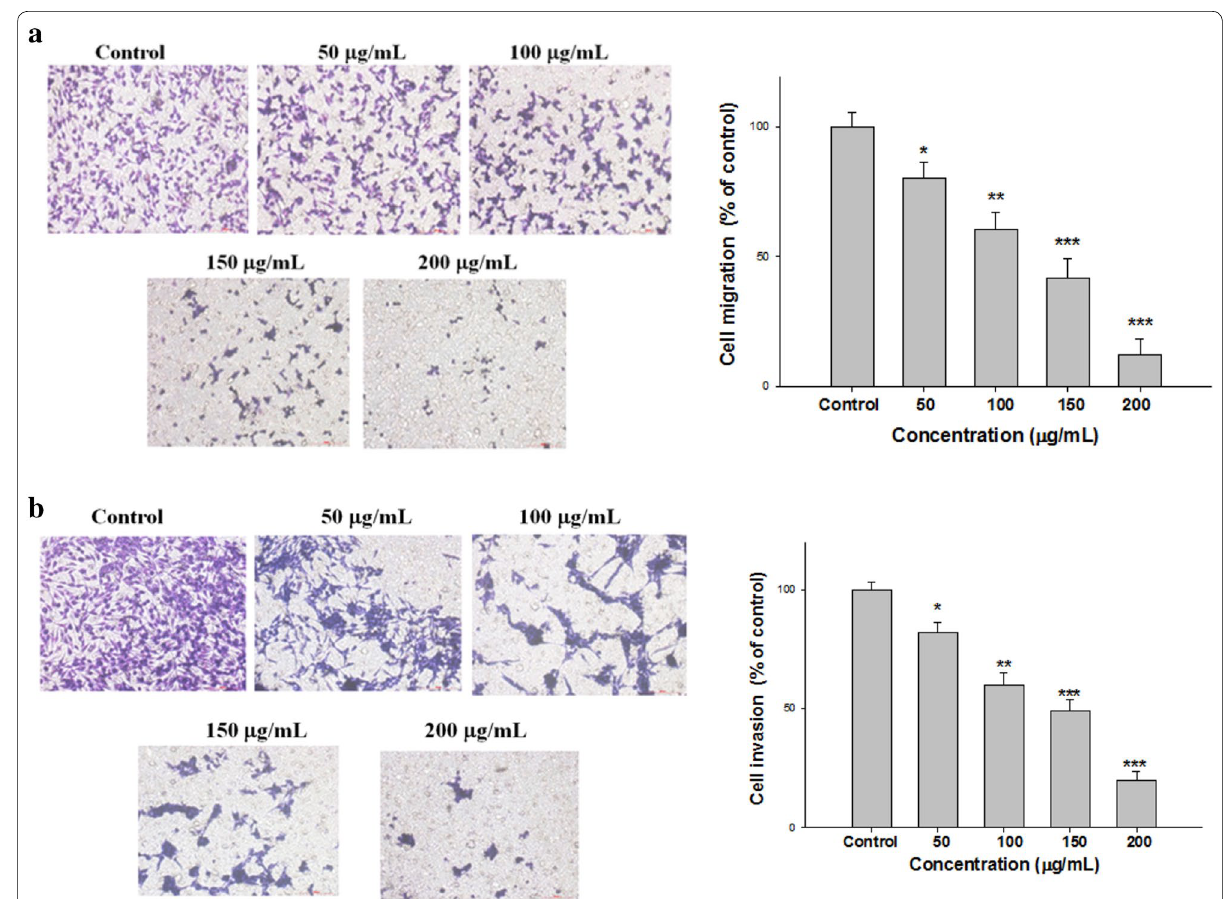
Fig. 3 Effects of EAAC on transwell migration ( a ) and invasion ( b ) of SK‑Hep1 cells. SK‑hep1 cells were incubated with EAAC (0, 50, 100, 150, and 200 μg/mL) for 24 h, and the transwell migration cells and invasion cells were counted. The data were presented as mean experiments performed in triplicate. * p < 0.05, ** p < 0.01, and *** p < 0.001 were compared with untreated control